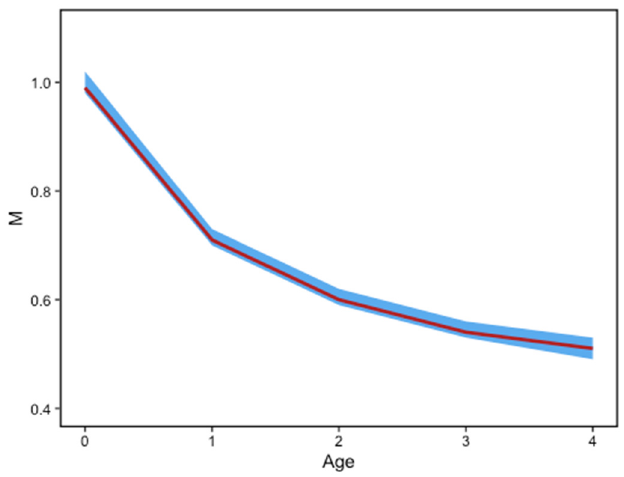
Figure 7. Sardine natural mortality (M) in GSA 16 based on Bayesian VBG parameters of selected years (2009–2015 excluding 2011): mean values, and lower and upper confidence intervals when uncertainty about the estimates of VBGP is propagated in the estimation of natural mortality using Gislason’s Second